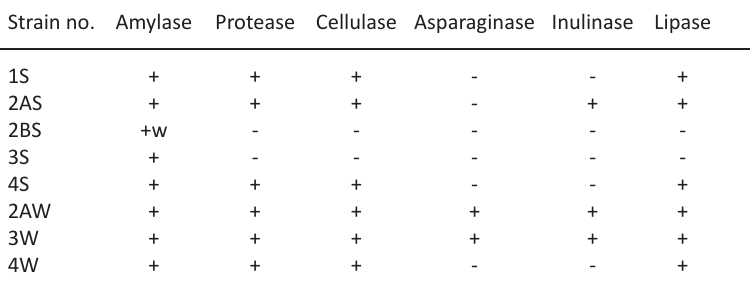
Table 4. Screening of industrially putative enzymes from isolated